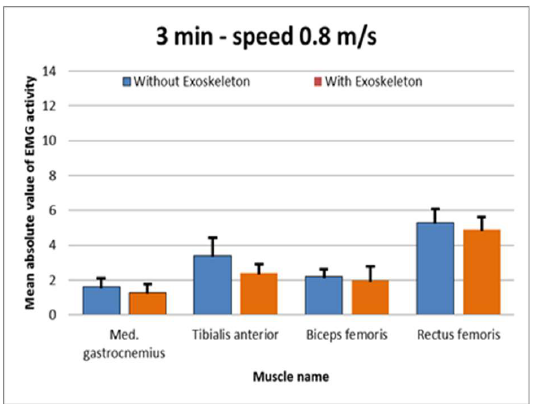
Fig. 14. Mean EMG activity of the right leg muscles of the subject with lower limb weakness during walking on treadmill at fixed speed 0.8m/s for 3